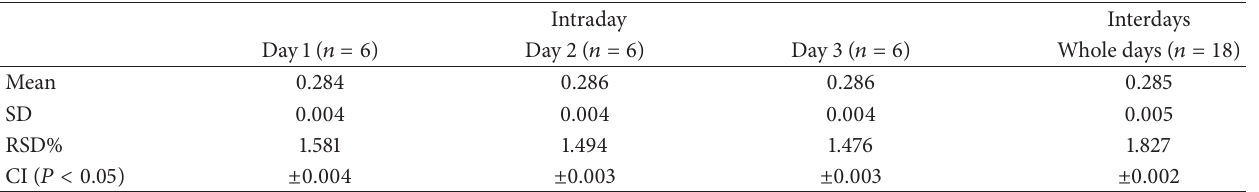
Table 1: Precision data for 1.79 𝜇 g/mL PIR.